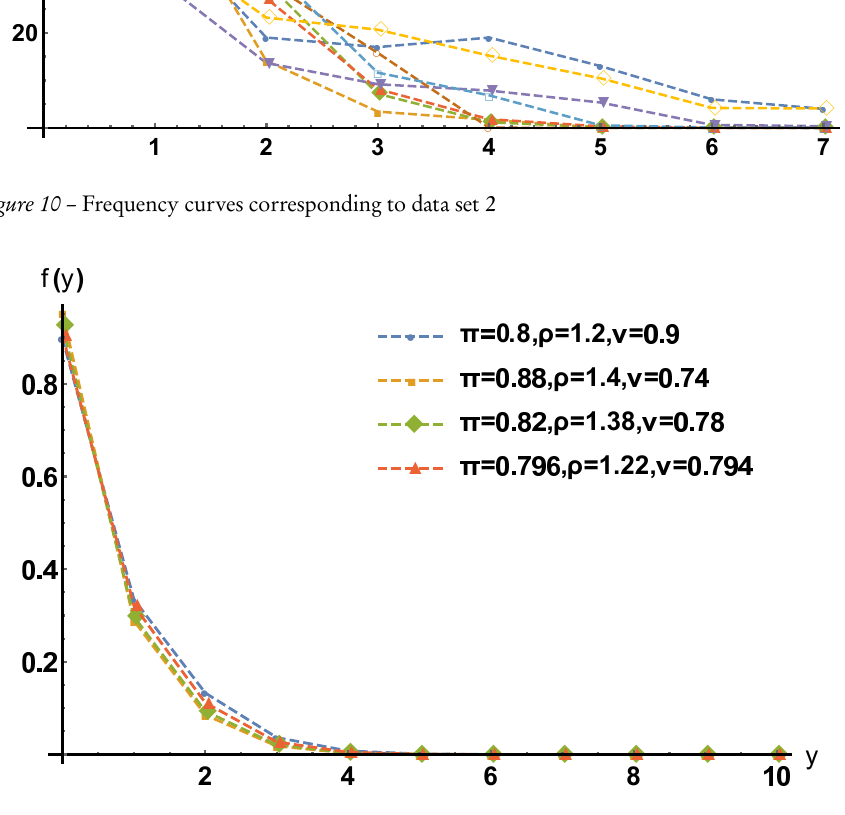
Figure 11 – Probability plots corresponding to parameter set